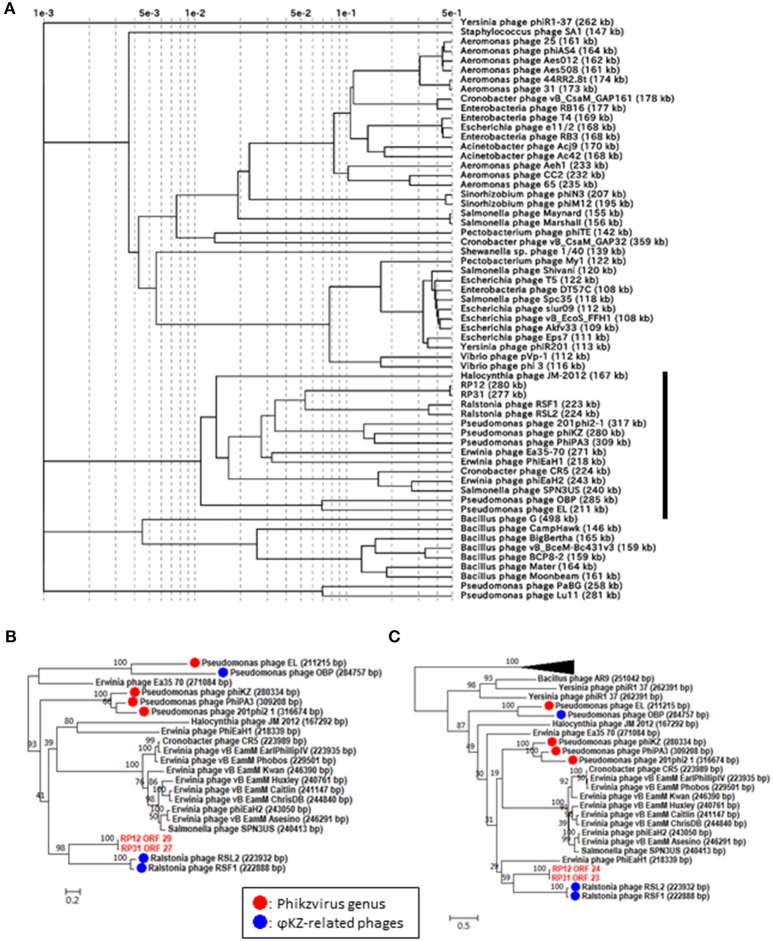
Proteomic and phylogenetic relationships between ΦRP12/ΦRP31 and other phages. (A) A proteomic tree produced by the BIONJ program (Gascuel, 1997) based on TBLASTX genomic sequence comparisons of 61 phage genomes. Branch lengths from the root were scaled logarithmically. In this logarithmic representation, nodes that were at distances smaller than 0.001 from the root were agglomerated into the root point. (B,C) Maximum likelihood phylogenetic trees of the tail sheath and terminase large subunit proteins, respectively. Statistical support at node is given as bootstrap values. Number at scale bar indicates the number of substitutions per site.